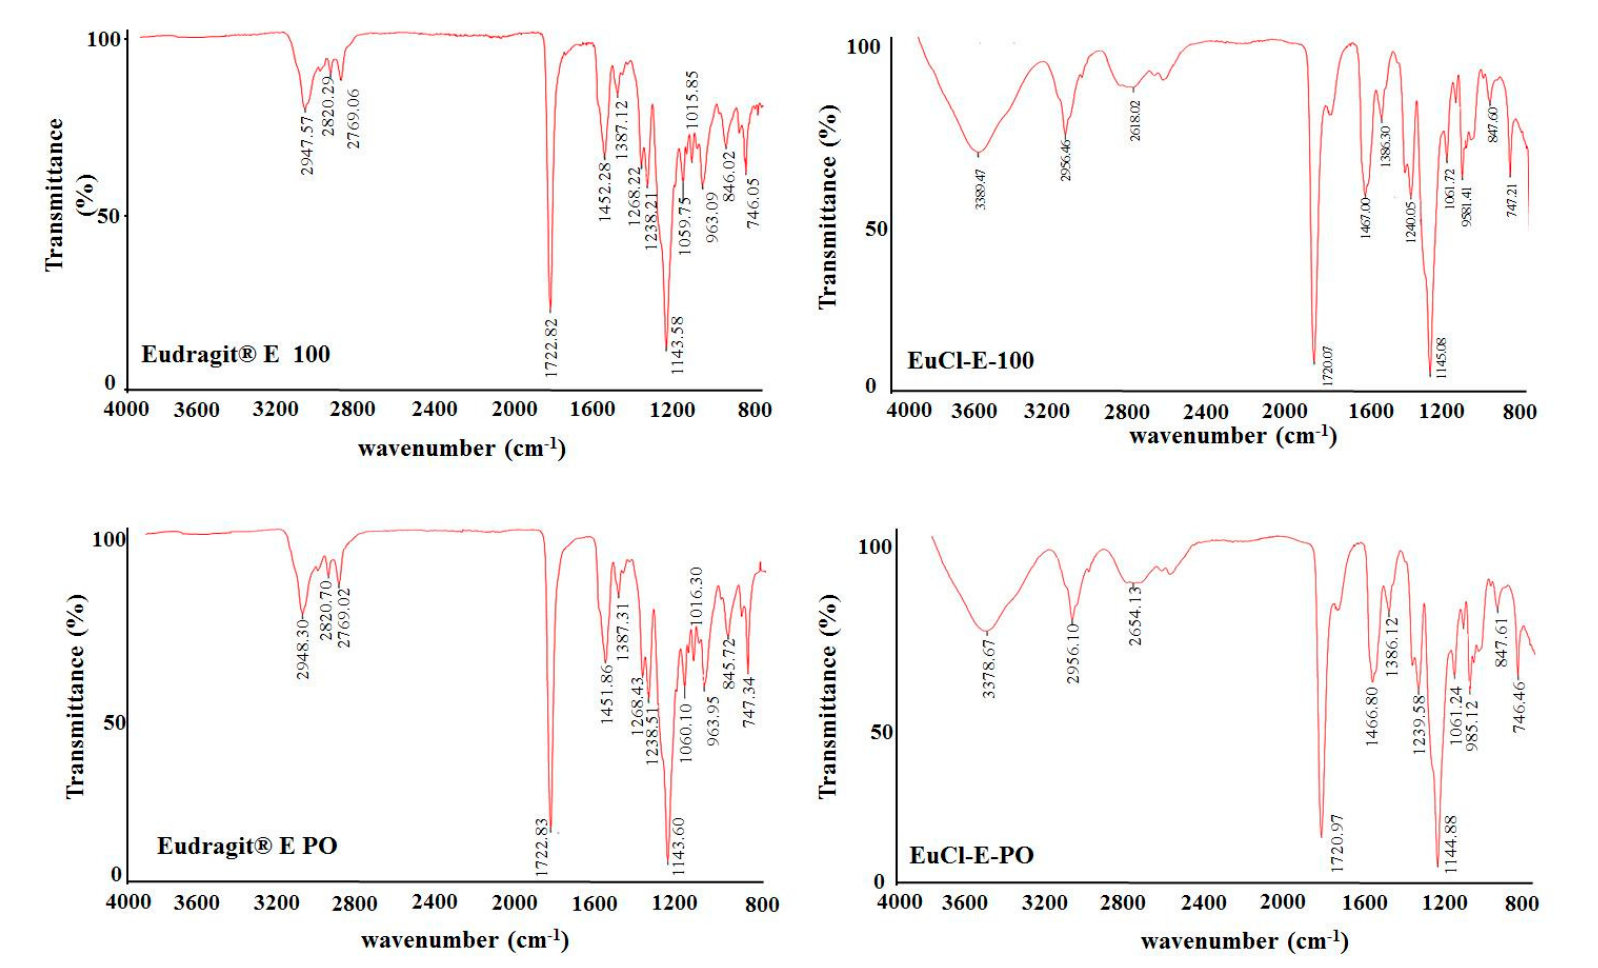
Figure 2. FTIR spectra of polymers derived from Eudragit